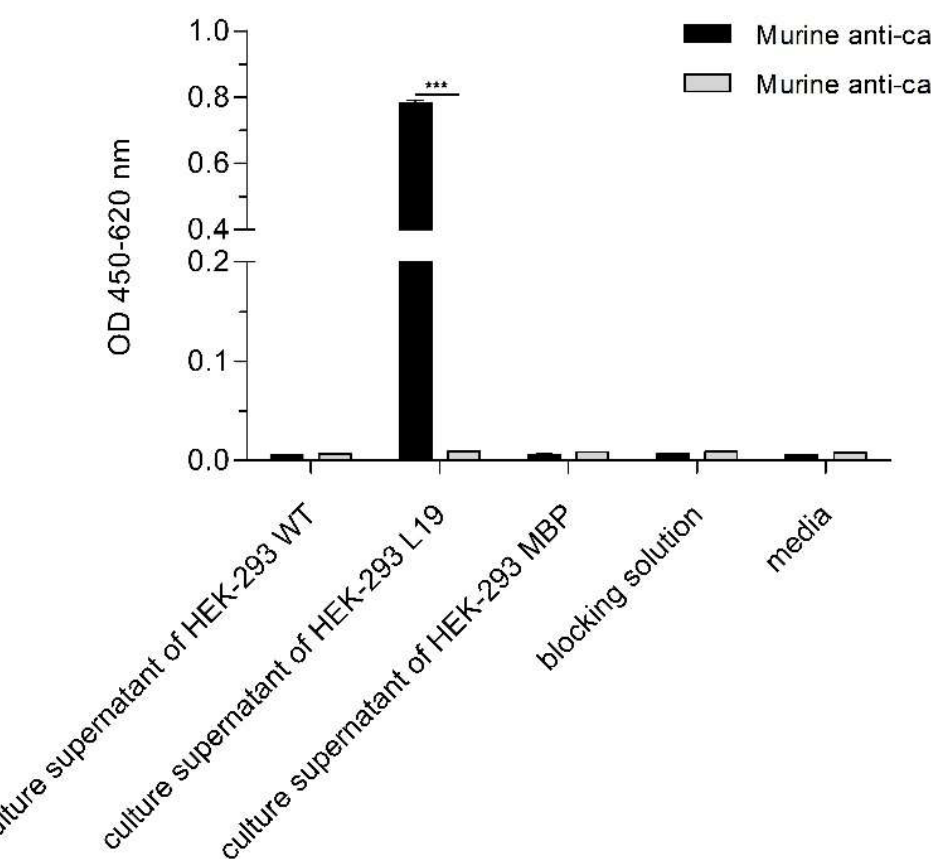
Figure 9. The culture supernatant of transfected HEK-293 cells was checked for the production of secreted L19. A murine anti-camelid IgG1/2/3 antibody (5 µg/mL) was coated onto the solid phase. Bound L19 antibodies were detected by the secondary HRP-labeled murine anti-camelid IgG2/3 and IgG1 antibodies (1:1000) discriminating between camelid IgG subclasses. The statistical signifi- cances between the different groups detected by two secondary antibodies were determined by an unpaired t -test with *** p < 0.001 (n = 3).